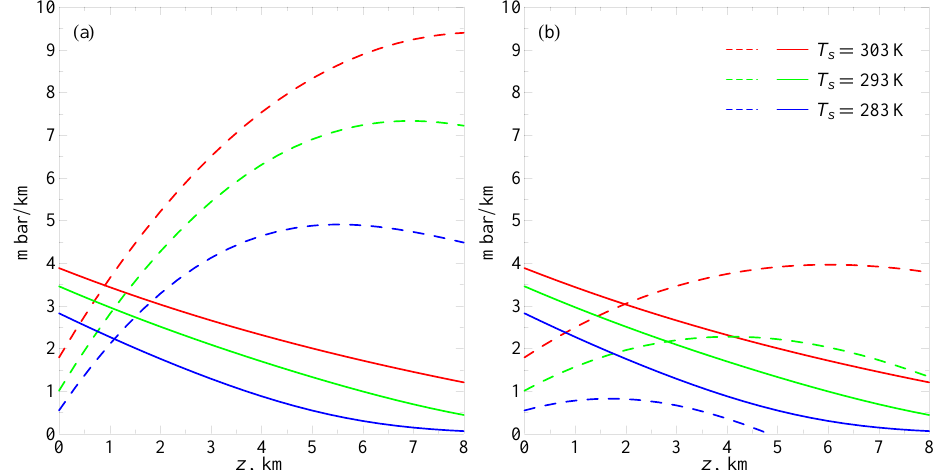
Fig. 2. Condensation force f C (solid curves) and buoyant force f B (dashed) acting at height z on a moist air volume ascending in an environment with dry adiabatic lapse rate 9.8Kkm − 1 (a) and mean tropospheric lapse rate 6.5Kkm − 1 (b) for different values of surface temperature T s